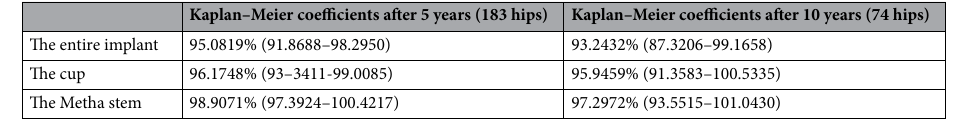
Table 4. Kaplan–Meier biofunctionality coefficients for installed implants after 5 and 10 years from the